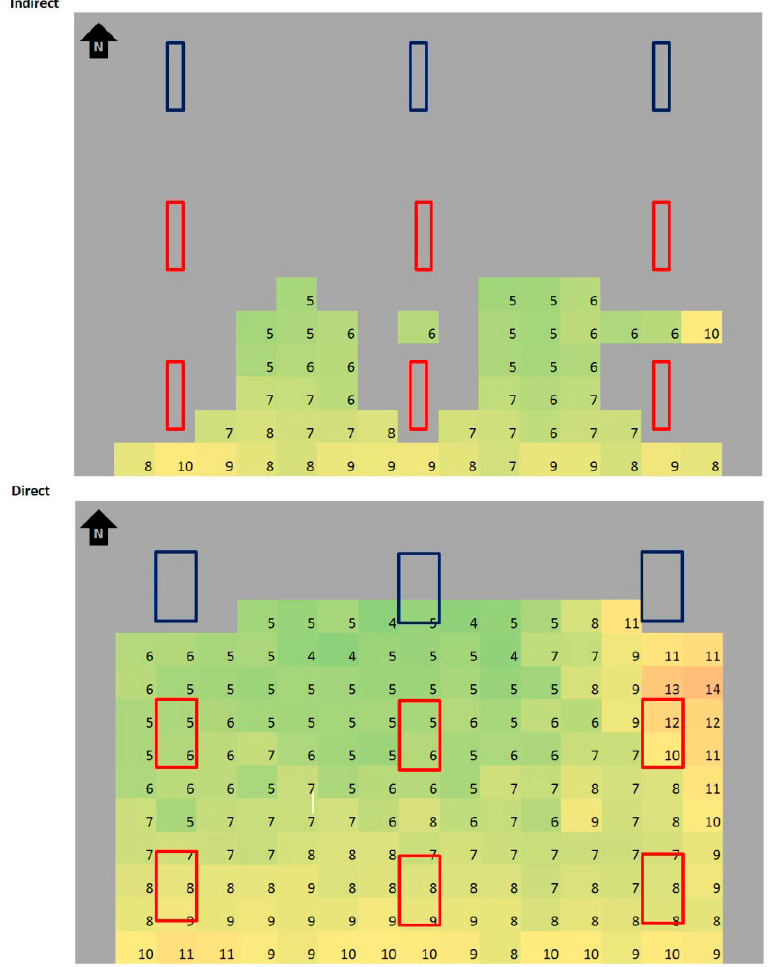
Figure 4. RMSE values from Figure 3 with sensor locations eliminated where the optimum algorithm requires a dimming level to signal slope that is steeper than a designated limit